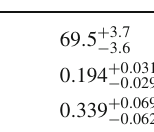
Table 2 Mean values and 95% CL for the parameters, H 0 ,